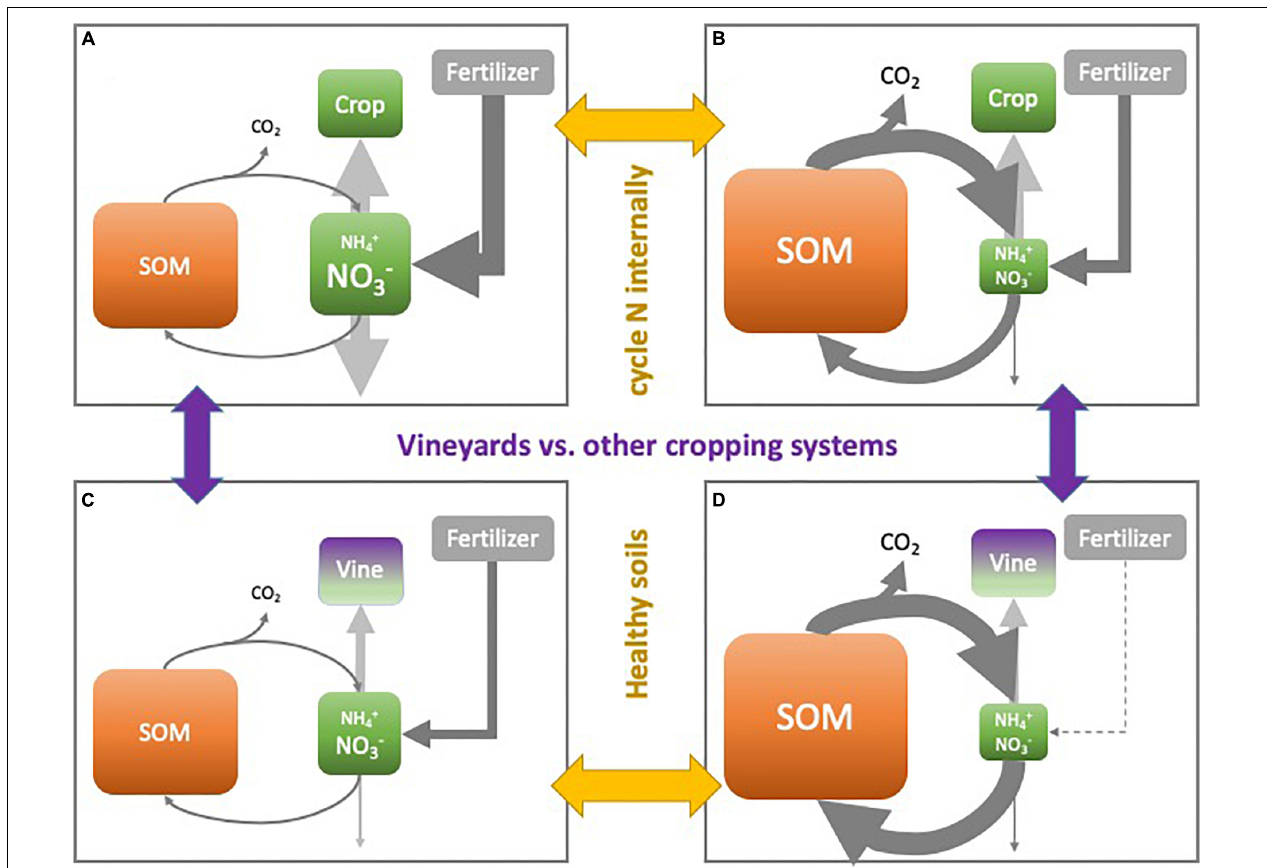
FIGURE 3 | Illustration of the N cycle for (A) conventional agricultural systems for crops with high N demand, (B) agricultural systems for crops with high N demand under soil health management, (C) conventional vineyard system, and (D) vineyards with soil health